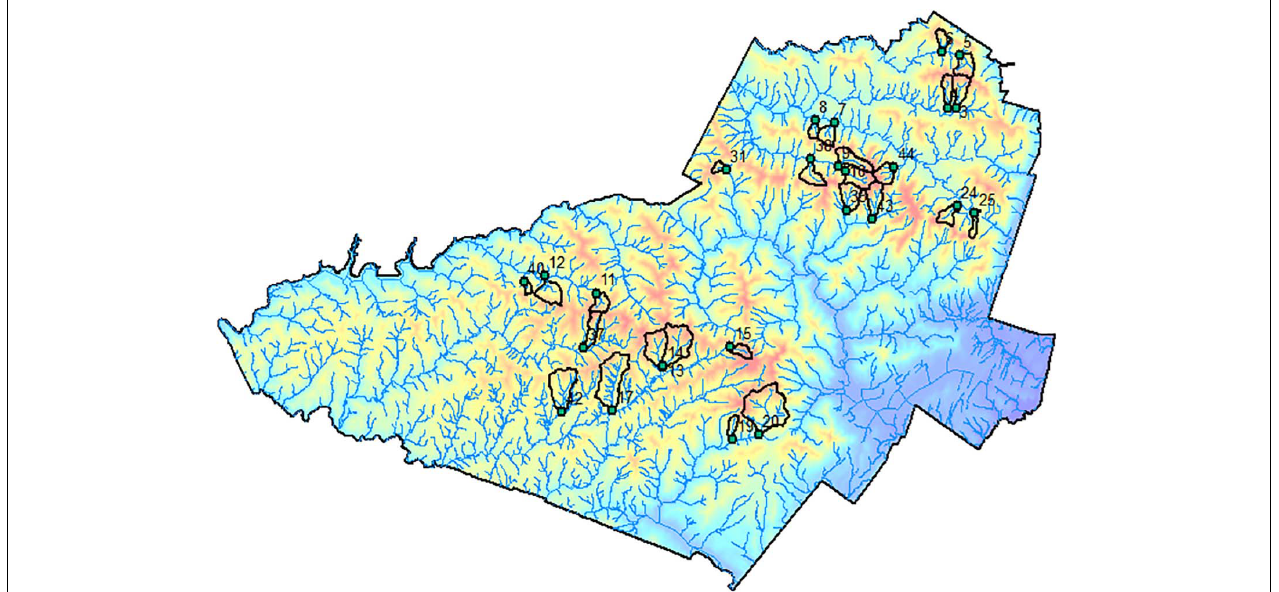
FIGURE 1 | Map of the Catskill Park in New York State with boundaries of the study watersheds and elevation